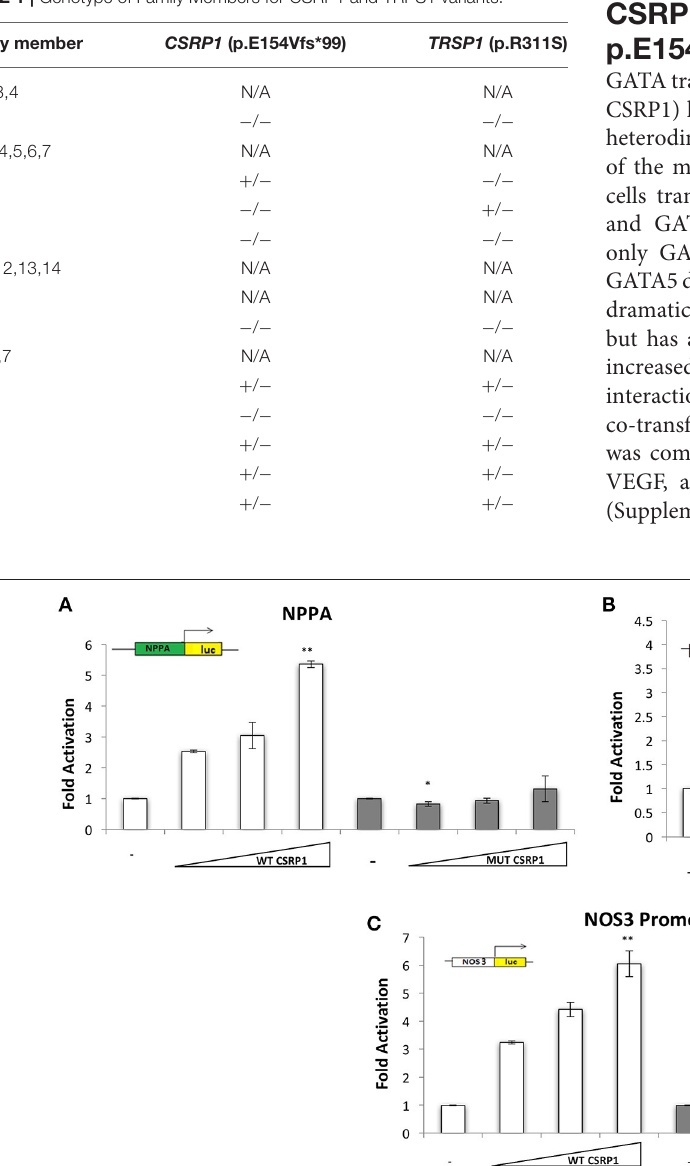
TABLE 1 | Genotype of Family Members for CSRP1 and TRPS1 variants.